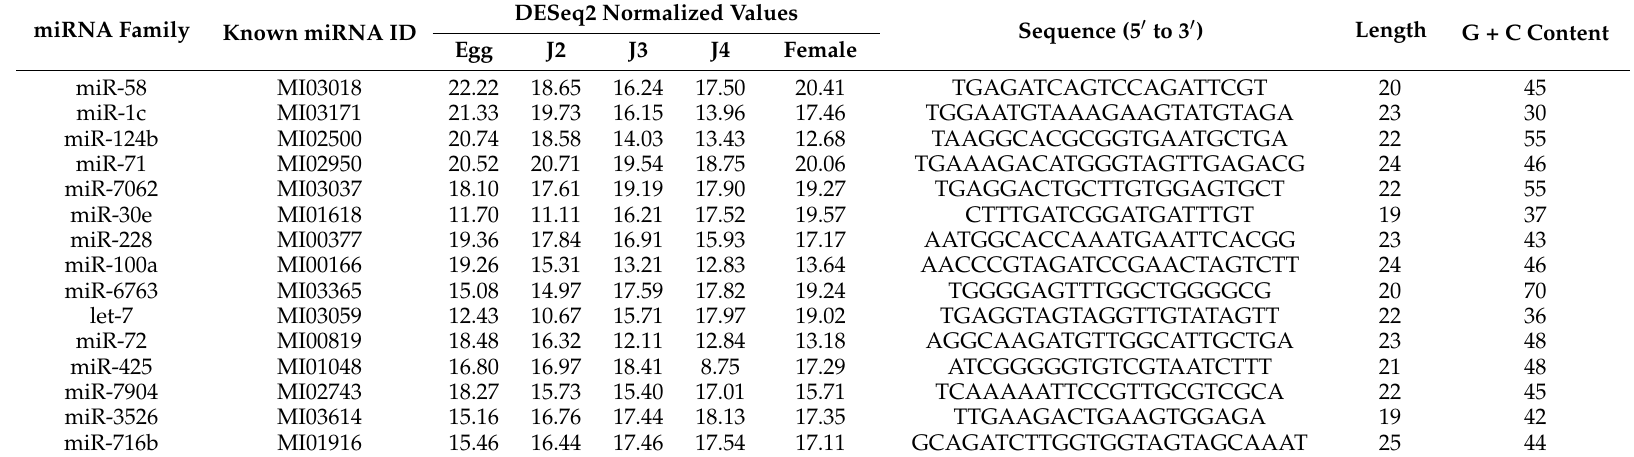
Table 3. Highly expressed known miRNA families of Meloidogyne incognita ( M. incognita